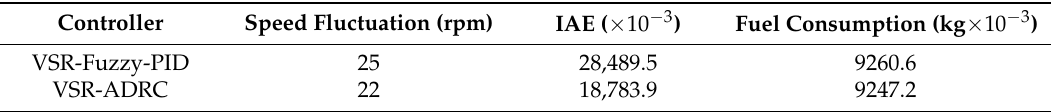
Figure 11. The control performance comparison between the VSR-Fuzzy-PID and VSR-ADRC controllers during the load disturbance conditions under changed engine model: ( a ) The speed responses; ( b ) the control input. Table 3. The performance comparison of different criterions for the controllers with wave load disturbances under changed engine model.